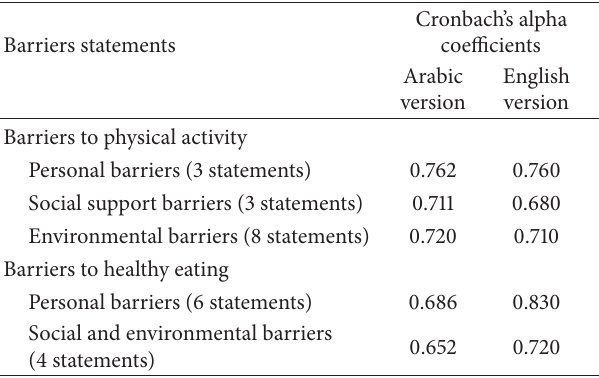
Table 1: Reliability of Arabic version of questionnaire as compared with original English version, using Cronbach’s alpha